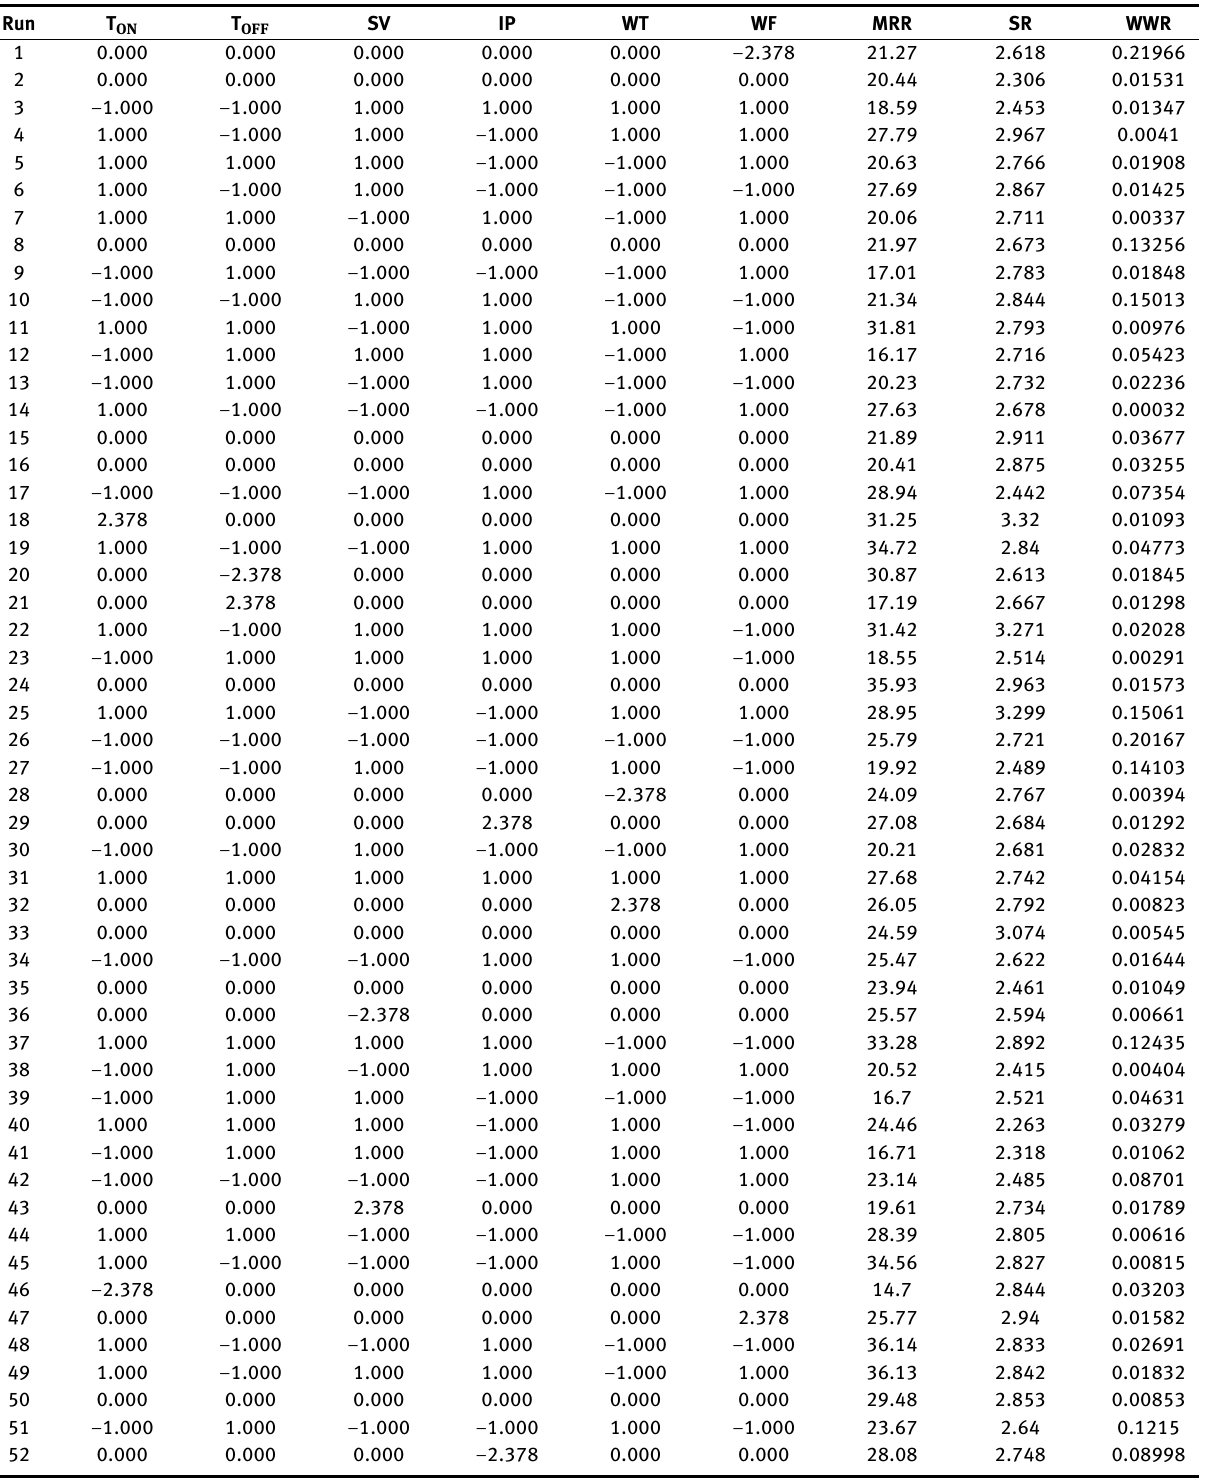
Table 3: Central composite design with actual